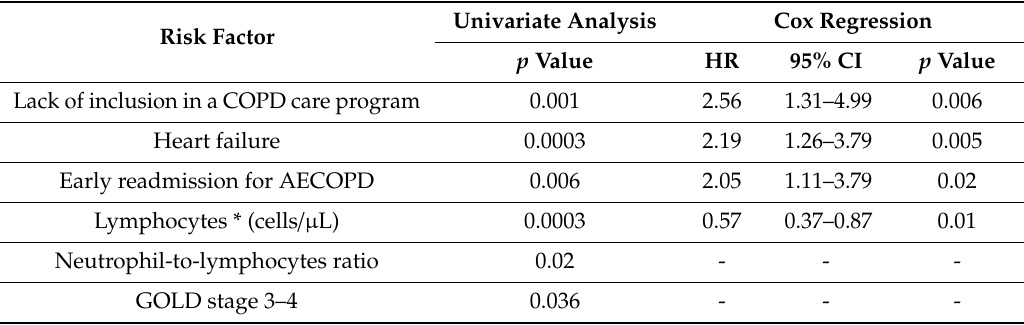
Figure 4. Causes of death. Pie chart showing the causes of death during the follow-up period. The most frequent causes were COPD exacerbations and cardiovascular events. Table 4. Risk factors for death, Cox proportional hazards